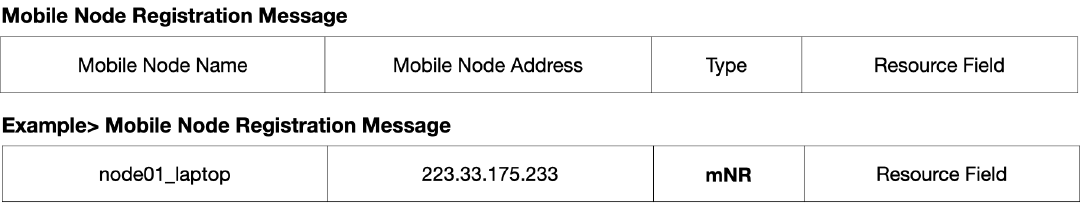
Figure 4. The mNR message format and example.